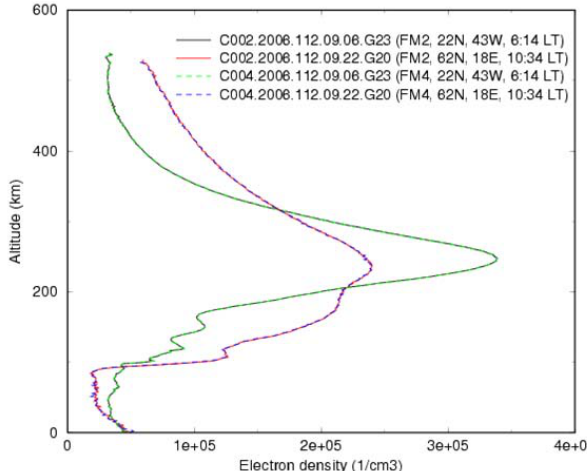
Fig. 8. Two pairs of different profiles of electron density obtained from FM-2 and FM-4 on 22 April 2006, seven days after launch when the spacecraft were very close together. FM-2 and FM-4 were within 30km of each other. At any given time, FM-2 was within 1km of where FM-4 was 4s later (source: UCAR CDAAC).